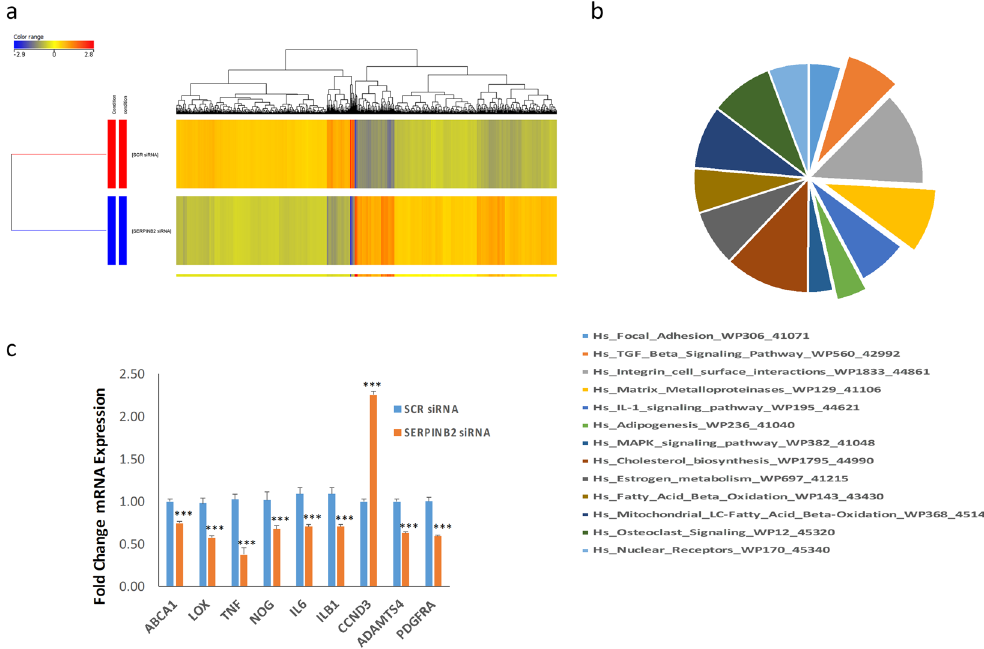
Figure 5. Gene expression profiling of SERPINB2-depleted hBMSC − Bone cells under osteogenic conditions. ( a ) Hierarchical clustering of SERPINB2-depleted hBMSC − Bone cells compared to scramble-siRNA transfected control cells, based on differentially expressed mRNA transcripts. The expression level of each gene in each condition is depicted according to the color scale shown. (b) Pie chart illustrating the distribution of top pathway designations for the de-regulated genes in SERPINB2-depleted hBMSC − Bone cells. (c) The expression levels of selected genes from the microarray data was validated using qRT-PCR in SERPINB2-depleted compared to Scrambled siRNA-transfected control hBMSC − Bone . Data are presented as the means ± SD from two independent experiments, n = 6; *** p <